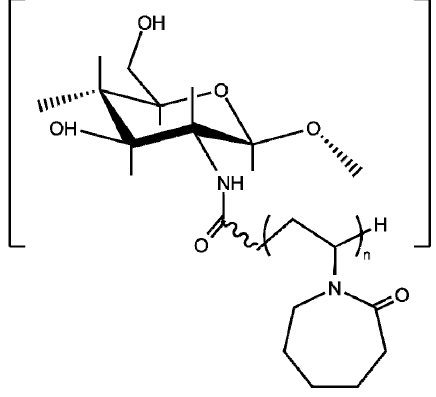
Figure 11. Chemical structure of chitosan- g -poly( N -vinyl caprolactam).